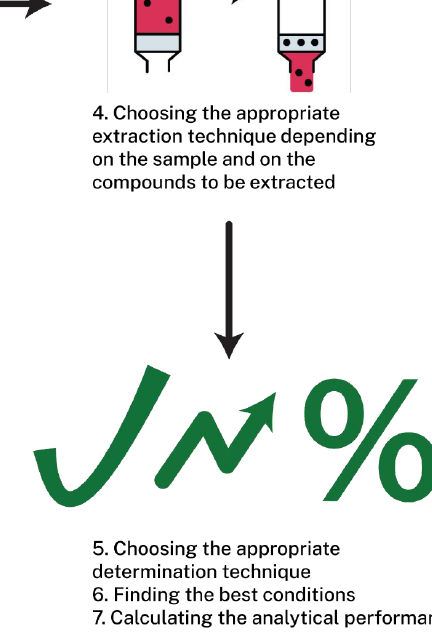
Figure 1. Representative scheme of the typical development of an extraction method by using deep eutectic solvents.